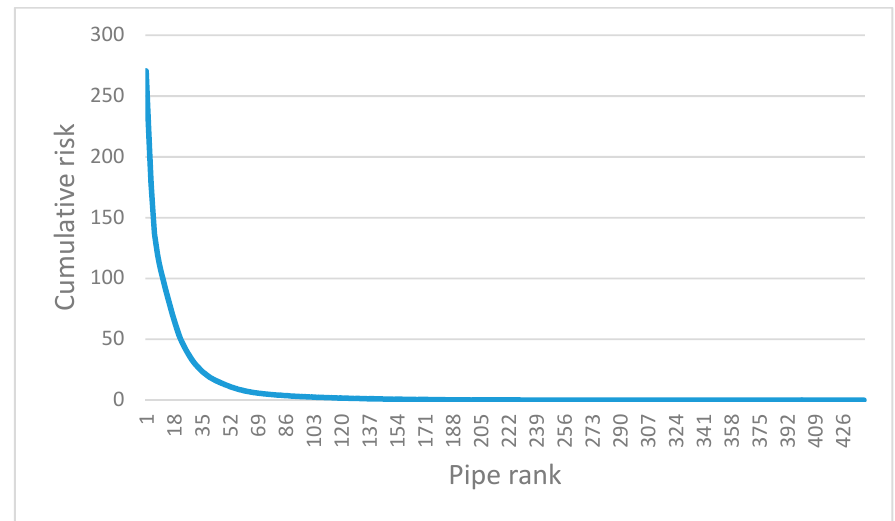
Figure 10. Cumulative risk calculated based on pipe ranking.